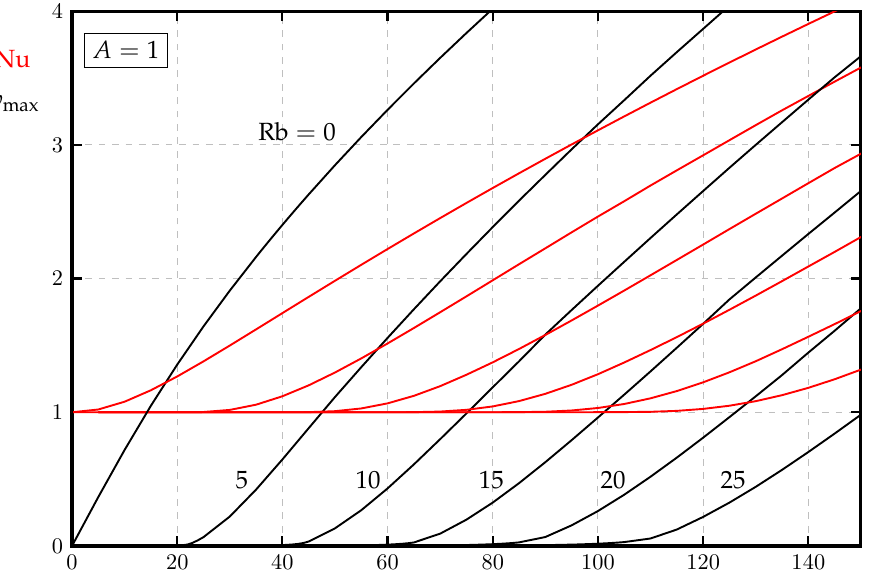
Figure 4. For an aspect ratio, A = 1, the variation with Ra of ψ max (black) and the Nusselt number, Nu (red) as Rb increases in steps of 5 from Rb = 0 to Rb = 25. Rb increases towards the right for ψ max and downwards for